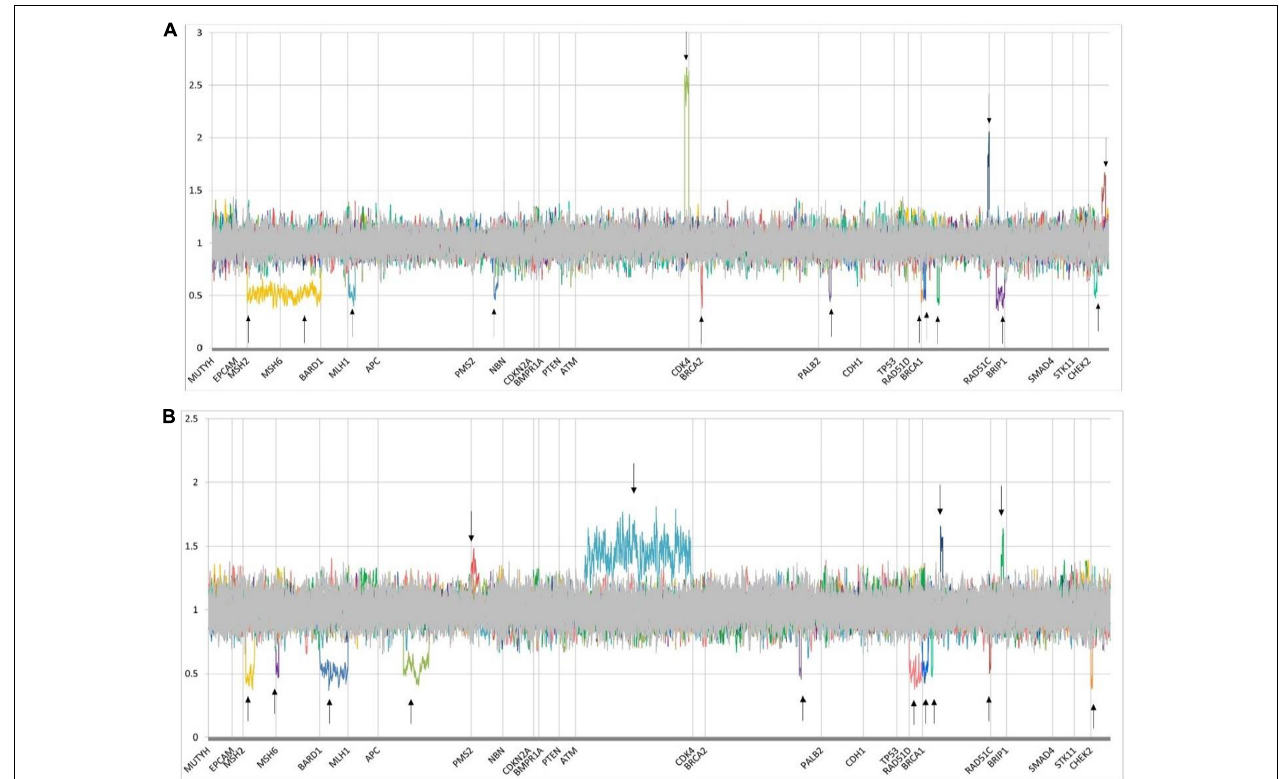
FIGURE 5 | Normalized copy number variant (CNV) plots demonstrating deletions and duplications in genes on the hereditary cancer panel. Y -axis represents quantile normalized copy number data (for unique autosomal genes, 0.5 indicates 1 copy; 1 indicates 2 copies; and 1.5, 3 copies; for homologous autosomal genes with their pseudogene, 0.75 indicates 3 copies; 1, 4 copies; and 1.25, 5 copies). Constitutional deletions are defined by a mean ratio of ≤ 0.65, and duplications are defined by a ratio of ≥ 1.35. Homologous region PMS2/PMS2CL deletions and duplications are assessed by a ratio of < 0.8 and > 1.2, respectively. X -axis indicates gene locations. From left to right, arrows represent patients with the following CNVs. (A) single patient with deletions in MSH2 and MSH6 genes [MSH2:c.(?_-21)_(*21_?)del/MSH6:c.(?_-21)_(*21_?)del] (represented by 2 arrows), pathogenic deletions of MLH1, PMS2, and